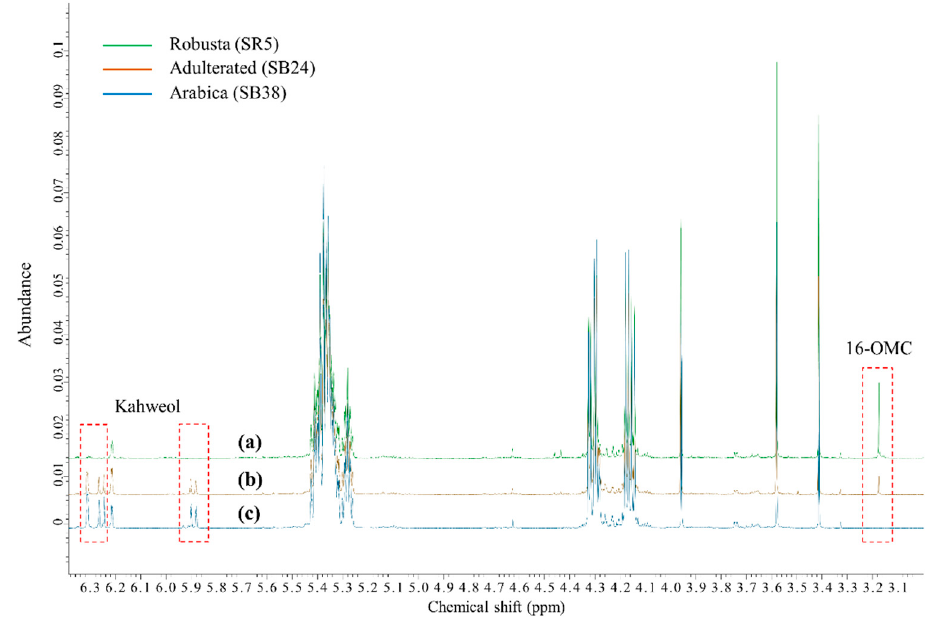
Figure 2. 1 H NMR spectra of the samples that were extracted from 100% Robusta ( a ), an adulterated blend ( b ) and 100% Arabica ( c ). The expanded region of marker peaks between 3.0 ppm and 6.4 ppm.